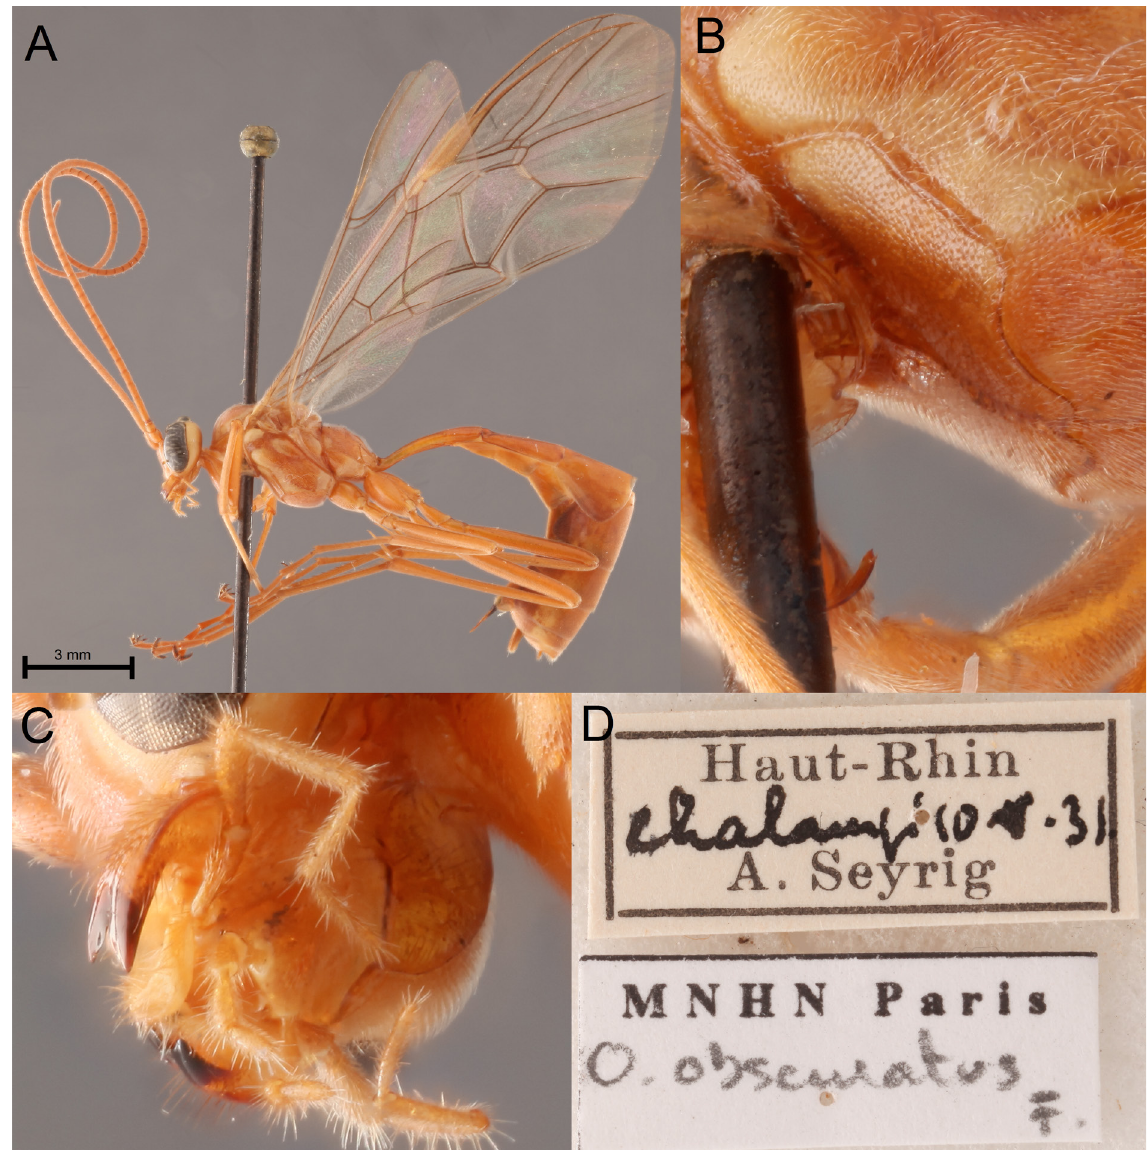
Fig. 50. Ophion variegatus Rudow, 1883, neotype, ♀ (MNHN). A . habitus, lateral view. B . Epicnemial carina, lateroventral view. C . occipital carina, lateroventral view. D .